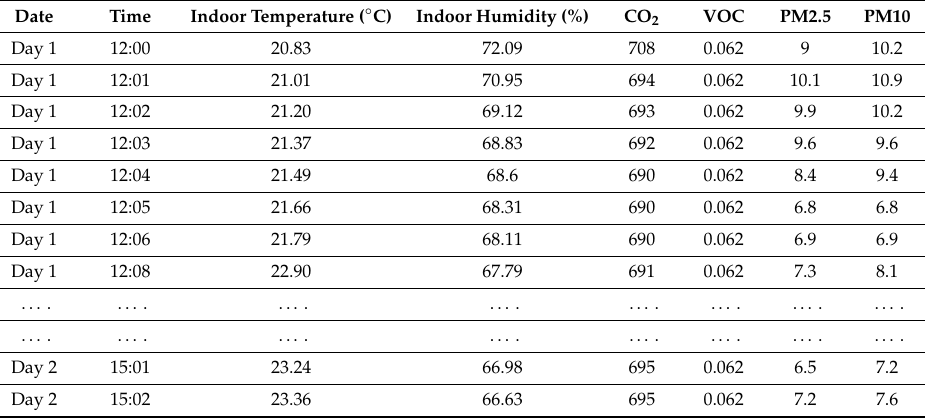
Table 5. Examples of data that describes the environmental conditions at